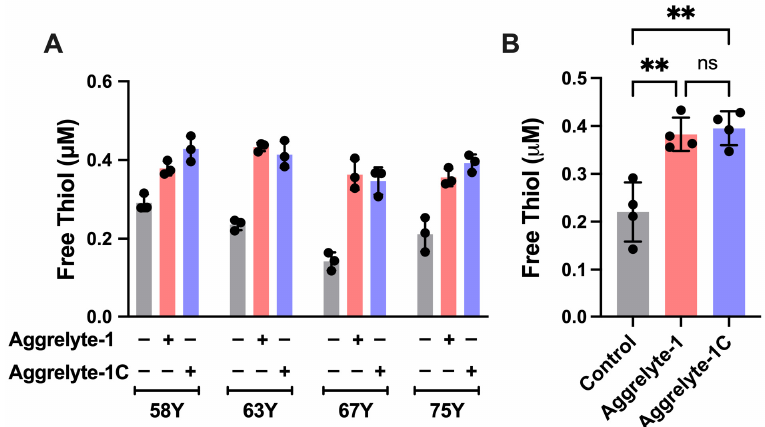
Figure 4. Aggrelytes increased the protein–thiol content in solubilized proteins. The protein–thiol content in the solubilized proteins of aged lenses (58, 63, 67, and 75 years old) was determined using a Thiol Quantification Assay Kit as described in the Methods. The data are shown as the mean ± S.D. for each sample processed three times separately and analyzed ( A ). A combined plot of the mean values of the three analyses of each sample is shown on the right ( B ). ** p < 0.01, ns = not significant.